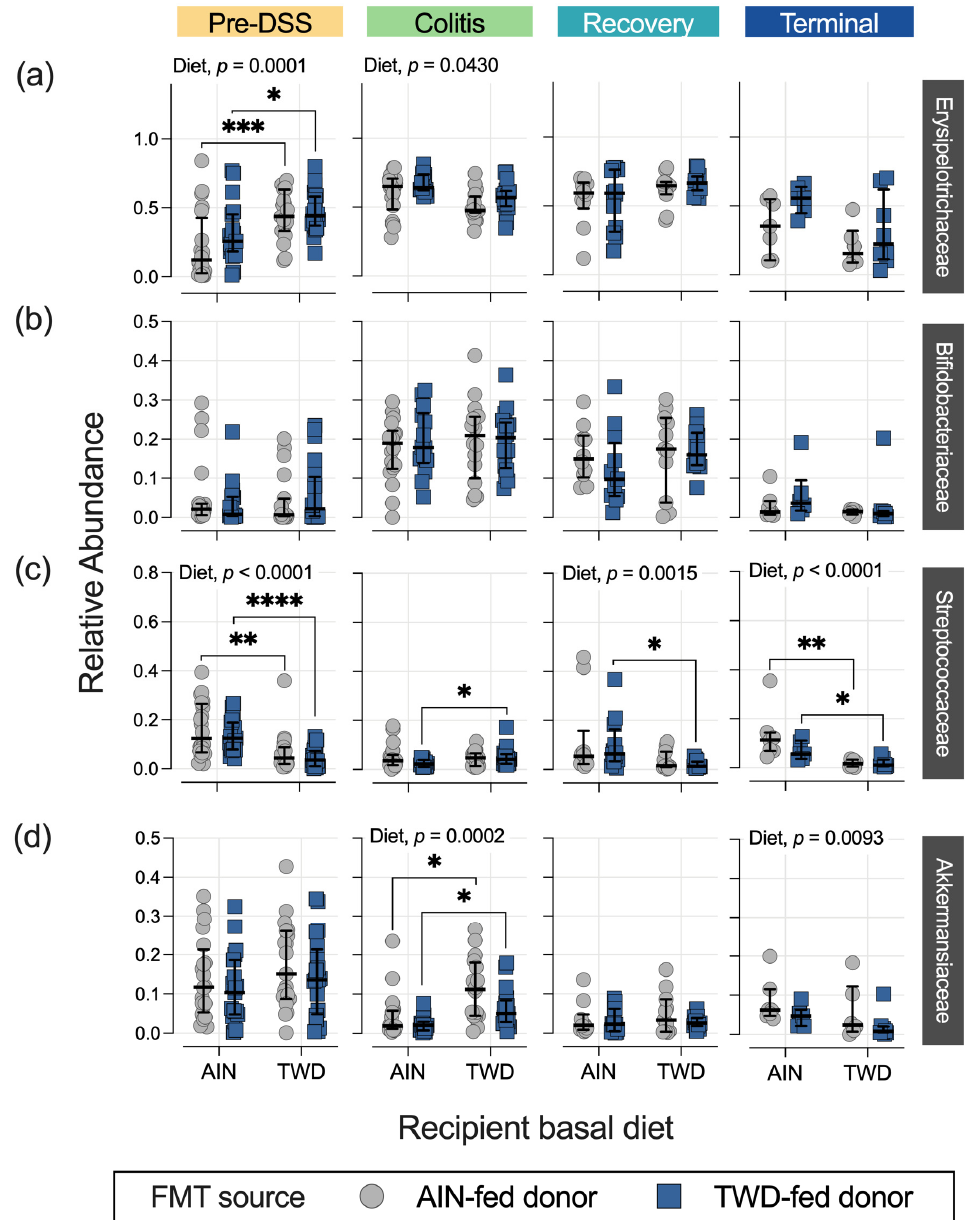
Figure 7. Relative abundance for selected bacterial families of interest at each experimental time point: ( a ) Erysipelotrichaceae, ( b ) Bifidobacteriaceae, ( c ) Streptococcaceae, and ( d ) Akkermansiaceae. The data are shown as individual values that represent each cage (as the biological unit) with median ± interquartile range ( n = 19 to 20 cages per group at the pre-DSS time point, n = 17 to 18 cages per group at the active colitis time point, n = 12 to 13 cages per group at the recovery time point, and n = 7 to 8 cages per group at the terminal time point). For simplified visualization, this plot shows only the statistical results as FDR-corrected p -values for significant main effects or the post hoc comparisons of FMT from the AIN-fed or TWD-fed donors: *, p < 0.05; **, p < 0.01; ***, p < 0.001; and ****, p < 0.0001, as outlined in the Materials and Methods section. The complete results of all metagenomeSeq statistical analyses, including pairwise comparisons by recipient basal diet and across time points, are provided in Supplementary File S2.